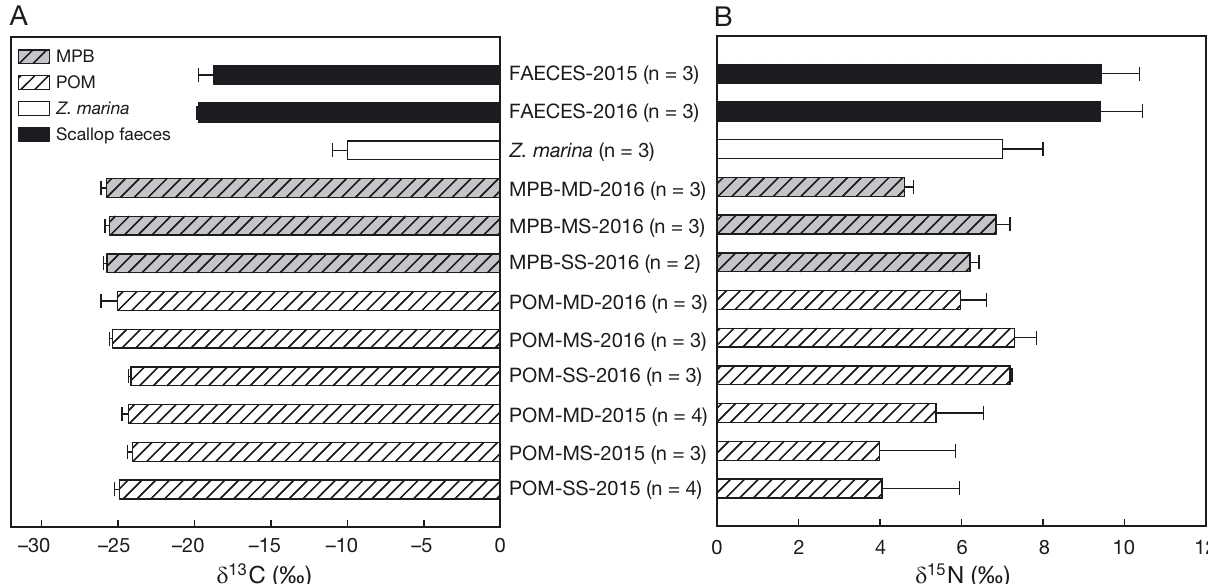
Fig. 1. Average stable (A) carbon and (B) nitrogen isotope signatures (mean ± SD for n replicates) of primary organic food sources of meiobenthos taxa collected from ‘farm’ and ‘control’ sites at 3 stations at scallop farms in Laizhou Bay, China in 2015 and 2016. Food sources analysed were scallop faeces, seagrass Zostera marina (isotopic values adopted from Hoshika et al. 2006), particulate organic matter (POM) and microphytobenthos (MPB). Stations were characterized by sediment type as sandy-shallow (SS), muddy-shallow (MS) and muddy-deep